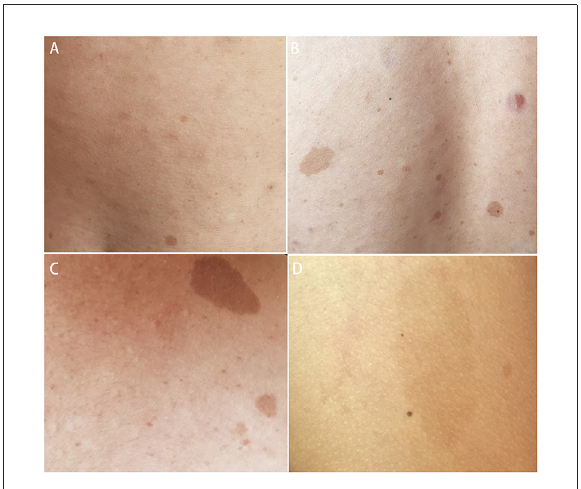
FIGURE1 Light brown plaques were seen on the chest and abdomen (A) , back (B) , shoulder (C) , and left upper arm (D)